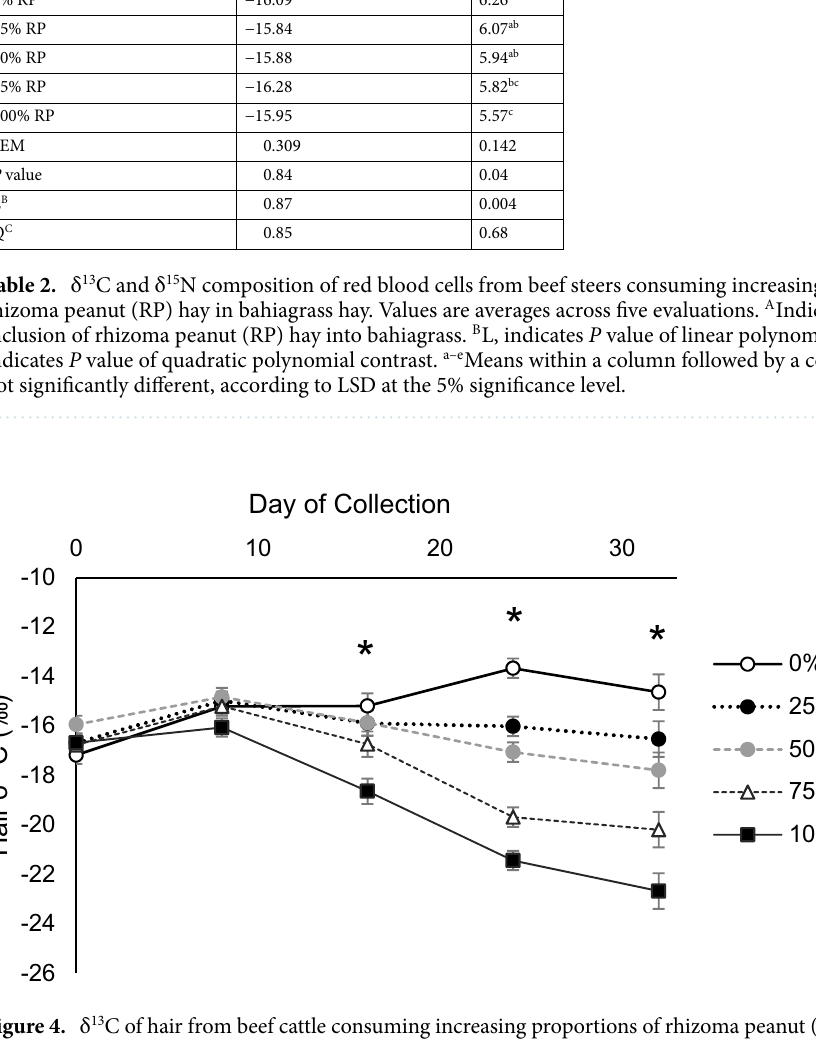
Figure 4. δ 13 C of hair from beef cattle consuming increasing proportions of rhizoma peanut (RP) in bahiagrass hay. Day of collection represents the number of days after dietary change. Asterisk indicates treatment differences ( P ≤ 0.05) exist within the day of